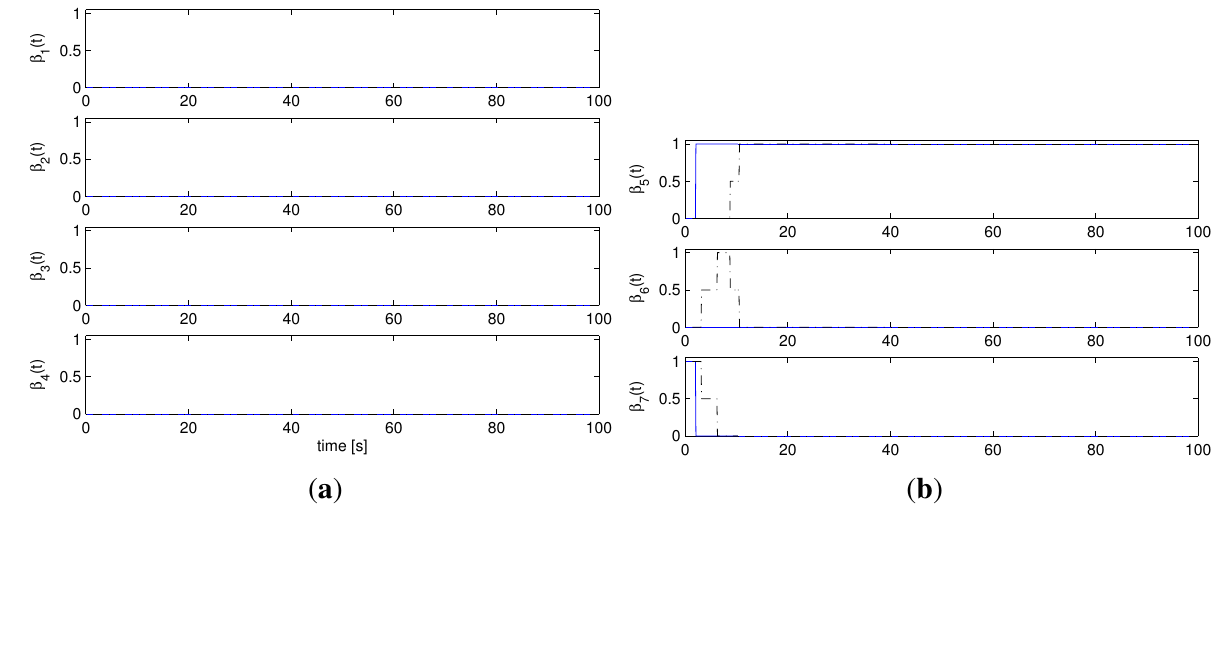
( t ) , β ( t ) , β ( t ) , β ( t ) ; ( b ) β ( t ) , β ( t ) , β ( t ) 1 2 3 4 5 6 7